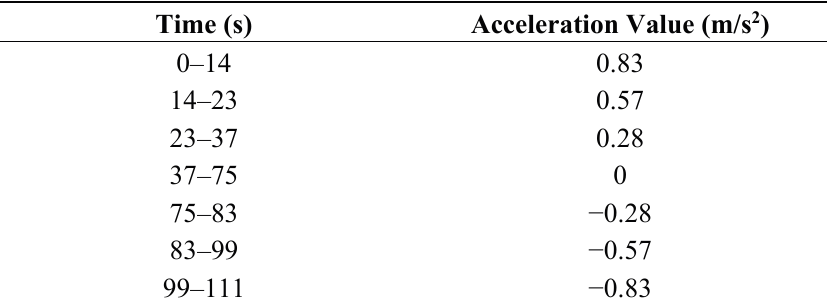
Figure 6. The experimental situation. Table 3. Working conditions of the whole running process